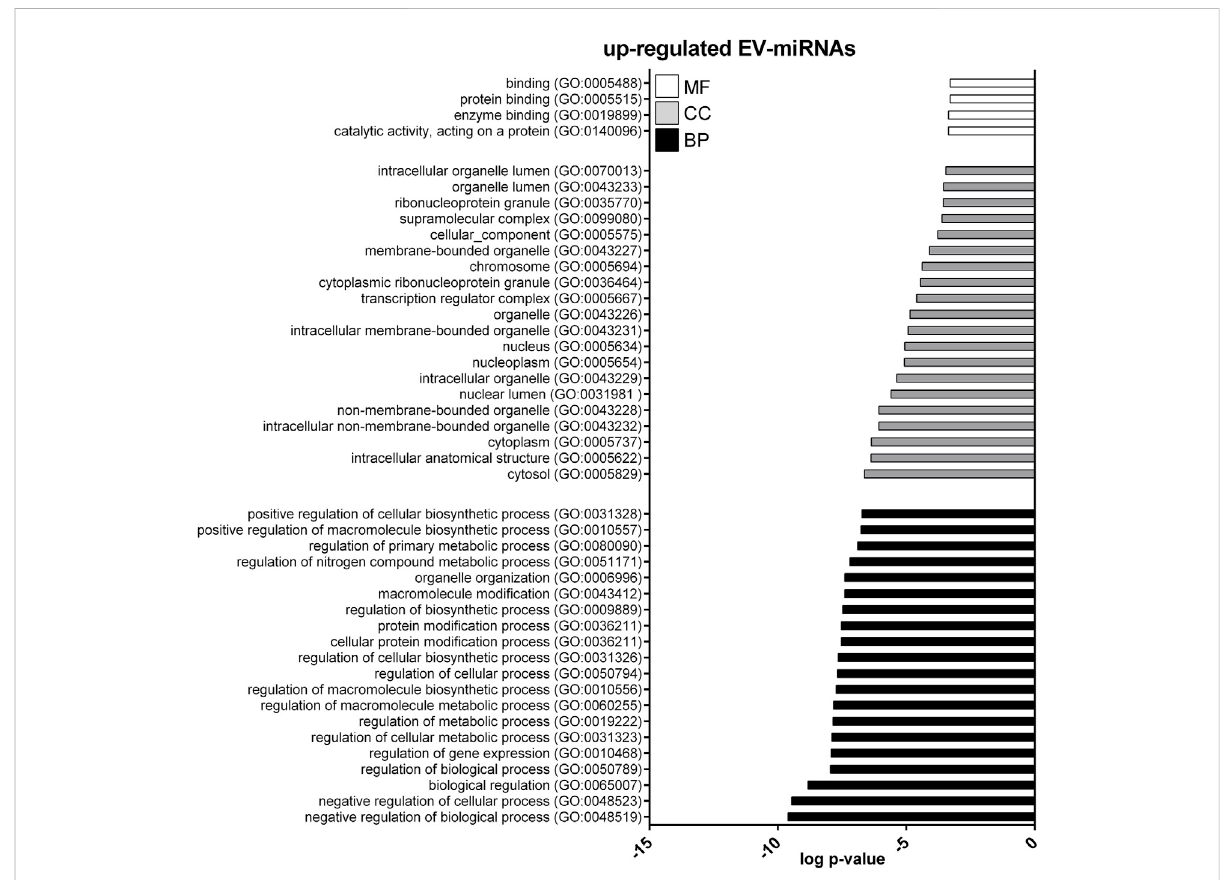
FIGURE 5 Gene ontology (GO) of predicted target genes for up-regulated EV-miRNAs. GO of 571 target genes predicted for up-regulated EV-miRNAs performed with Panther ver 17.0 (http://www.pantherdb.org/). Genes were classi fi ed based on biological processes, cellular component, and molecular function. The fi rst 20 most enriched terms were shown. Statistical overrepresentation tests showing the p -value of each category are shown in Supplementary Table